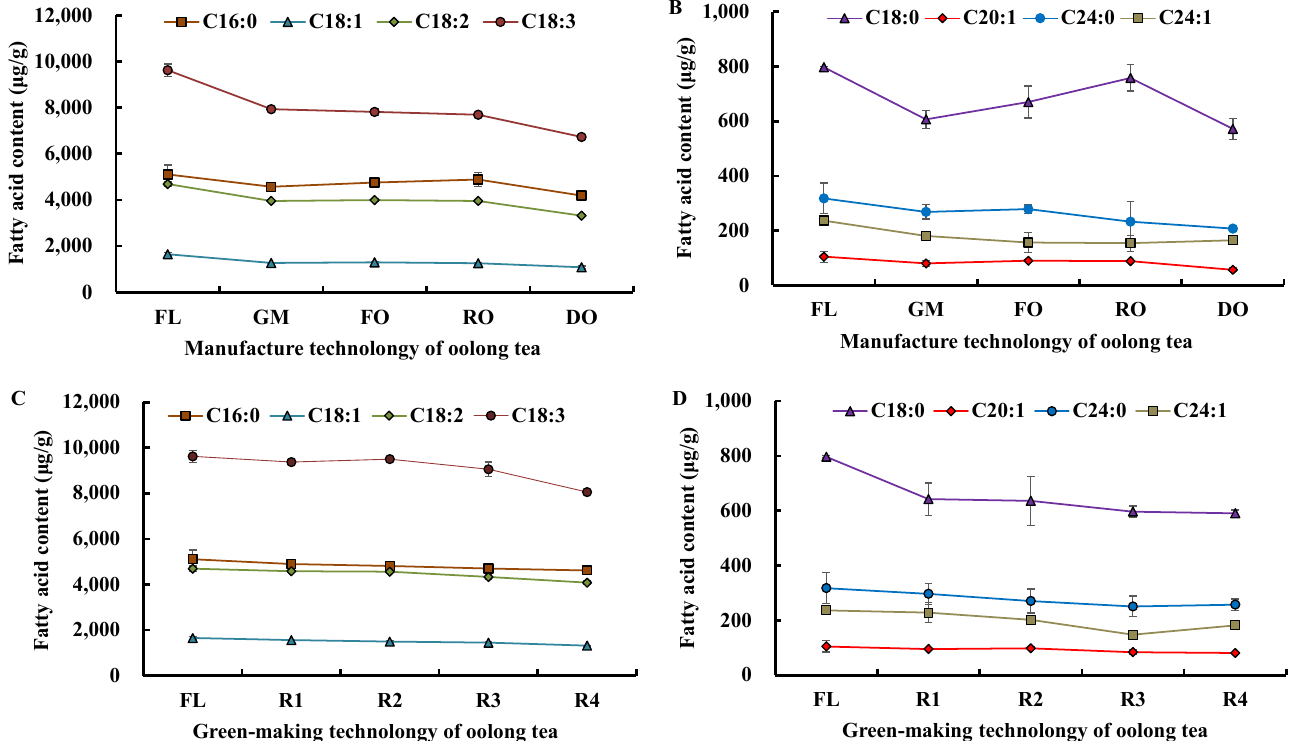
Figure 3. Manufacturing technology influence on fatty acids composition. ( A ) C16:1, C18:1, C18:2, and C18:3 changed during oolong tea making; ( B ) C18:0, C20:1, C24:0, and C24:1 changed during oolong tea making; ( C ) C16:1, C18:1, C18:2, and C18:3 changed during the green-making stage; and ( D ) C18:0, C20:1, C24:0, and C24:1 changed during the green-making stage. FL, GM, FO, RO, and DO indicate fresh leaves, green-making step, fixation of oolong tea, rolling of oolong tea, and drying of oolong tea, respectively; FL, SP, FG, RG, and DG indicate fresh leaves, spreading, fixation of green tea, rolling of green tea, and drying of green tea, respectively; and FL, R1, R2, R3, and R4 indicate fresh leaves, 1st turnover, 2nd turnover, 3rd turnover, and 4th turnover of oolong tea,